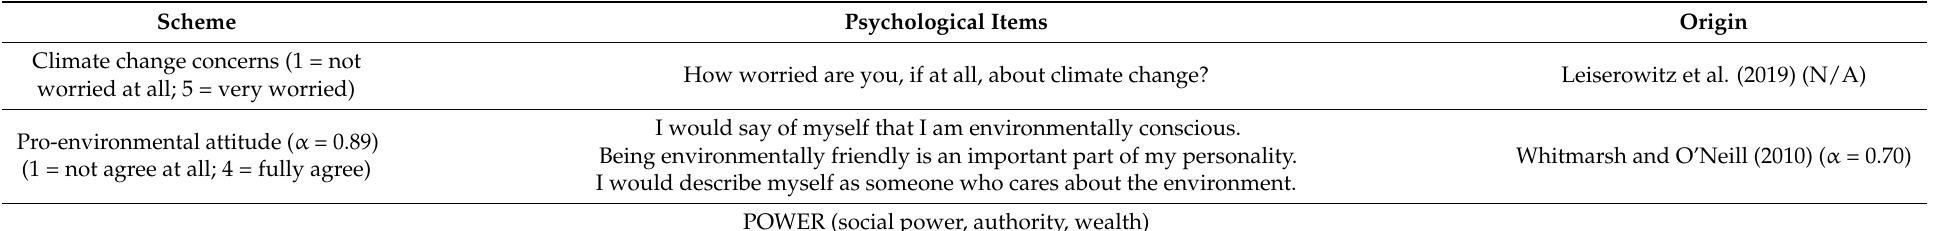
Table A2. Psychographic measurement scales and items with